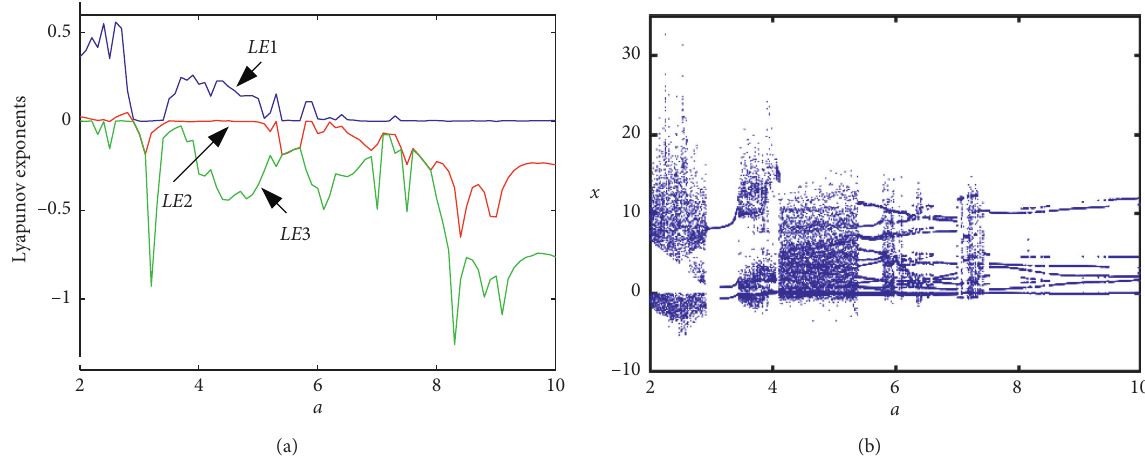
Figure 5: Lyapunov exponent spectra and bifurcation of system (4) with b � 3, c � 5, d � 0.75, and k � 1, and a varies in [2, 10]: (a) Lyapunov exponent spectra: LE 1 is blue, LE 2 is red, and LE 3 is green; (b) bifurcation